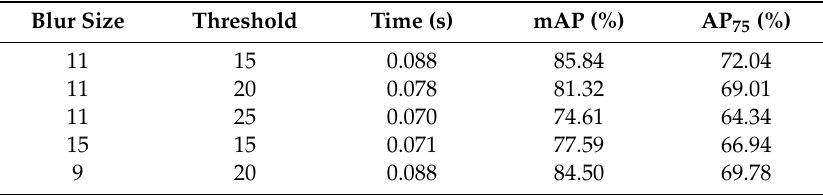
Table 1. Results of the original framework with downsampling.